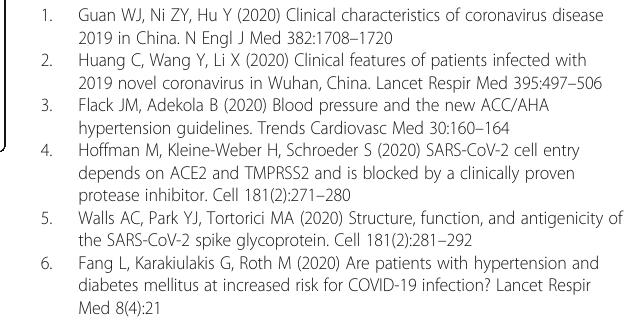
Additional file 1: Figure 1. Schematic search strategy results in the standardized PRISMA flow diagram. Figure 2. A) Random effect model of pooled hazard ratio comparison: Outcome of ACEi/ARB. B) Overall estimate of study publication bias scattered in funnel plot. Figure 3. Additional adjusted meta-analysis of studies in subgroup 1 (A) and sub- group 2 (B). Estimate of subgroup 1 (C) and subgroup 2 (D) publication bias scattered in funnel